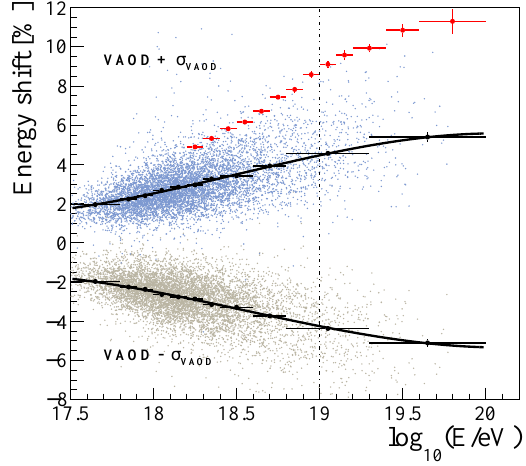
Figure 5. Auger energy-dependent reconstruction bias due to the aerosols. Black curves indicate the expected average energy shift of 1% per decade above 10 EeV for Auger, if the Auger VAOD is increased (top curve) or decreased (bottom curve) by its uncertainty σ VAOD . The dots show the energy shifts for each FD event. Red dots show the expected average energy shift of 2% per decade above 10 EeV for an extreme case scenario.